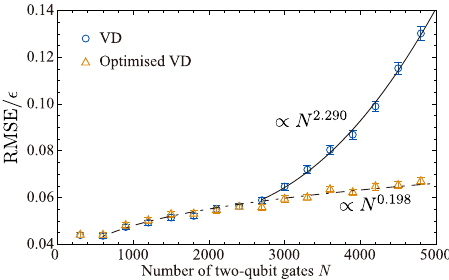
Fig. 10 Root mean square errors (RMSE) in virtual distillation (VD) protocols. The error bar represents one standard deviation. Other details such as the circuit con fi guration and error model are the same as Fig.